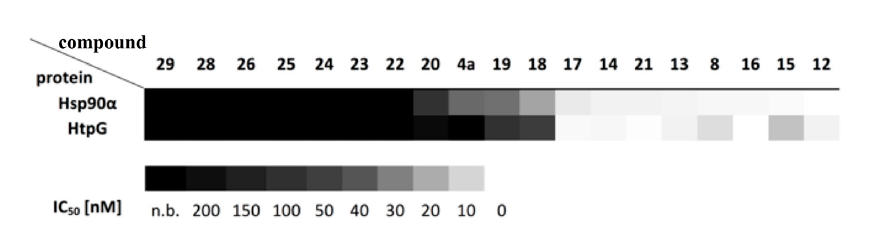
Figure 2b. Heat map of the calculated IC values of HSP90α from H. sapiens, HtpG from 50 H. pylori and HSP83 from A. thaliana for several tested potential inhibitors in a competitive displacement assay. Numbers as indicated have been described before [13]. Different grey tones from black to white indicate the potency of the inhibitor. White corresponds strong inhibitory effects, whereas black shows no effects for the competition with ATP for the binding pocket.